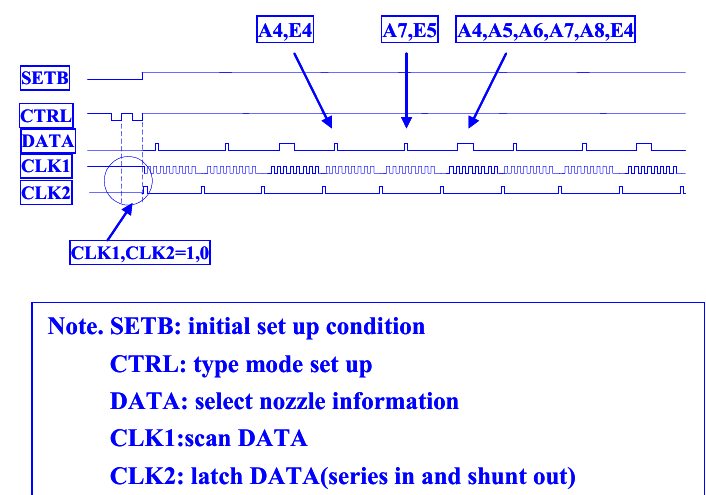
Figure 2. Input signal of the inkjet driver chip.